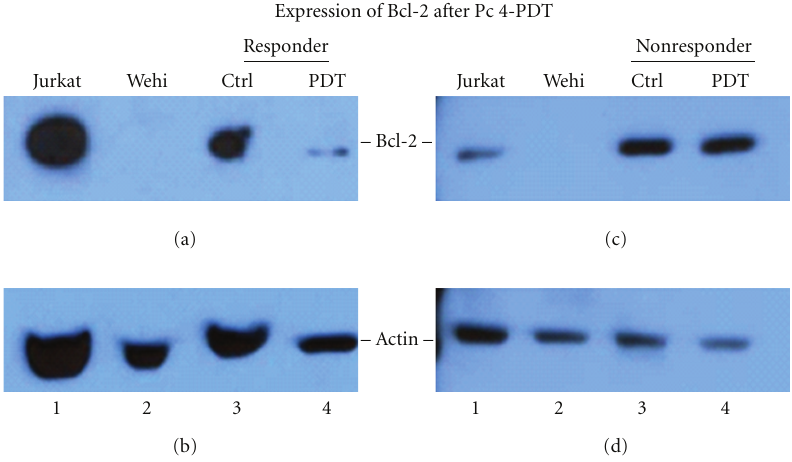
Figure 5: Representative Western blots of Bcl-2 expression after in vivo treatment with Pc 4-PDT. Skin biopsies of MF lesions were obtained from patients diagnosed with MF. This Western blot compares Bcl-2 expression in a single representative clinical responder to that of a single representative clinical nonresponder. The top panels in both (a) and (c) show the 26 KDal Bcl-2. (b) and (d) show bands corresponding to actin as loading control. For both the responder (a and b) and nonresponder blots (c and d), Lane 1 consists of Jurkat cells, a cell line known to have endogenous expression of Bcl-2. Lane 2 consists of Wehi cells, a mouse cell line known to have minimal endogenous Bcl- 2 expression. Lanes 3 and 4 contain the extraction from the untreated and treated lesions, respectively. (a) The clinical responder patient shows significantly decreased Bcl-2 expression in treated lesions in comparison to Bcl-2 expression in untreated lesion. In Lane 2, there is no corresponding band, as expected. (b) In the clinical nonresponder patient, again, there is Bcl-2 expression detected in Jurkat cells and no expression in Wehi cells, as expected. However, in contrast to the clinical responder patient, the level of Bcl-2 expression in treated and untreated lesions of the nonresponder is similar. These results are supported by the level of actin protein, which shows approximately similar amounts of protein